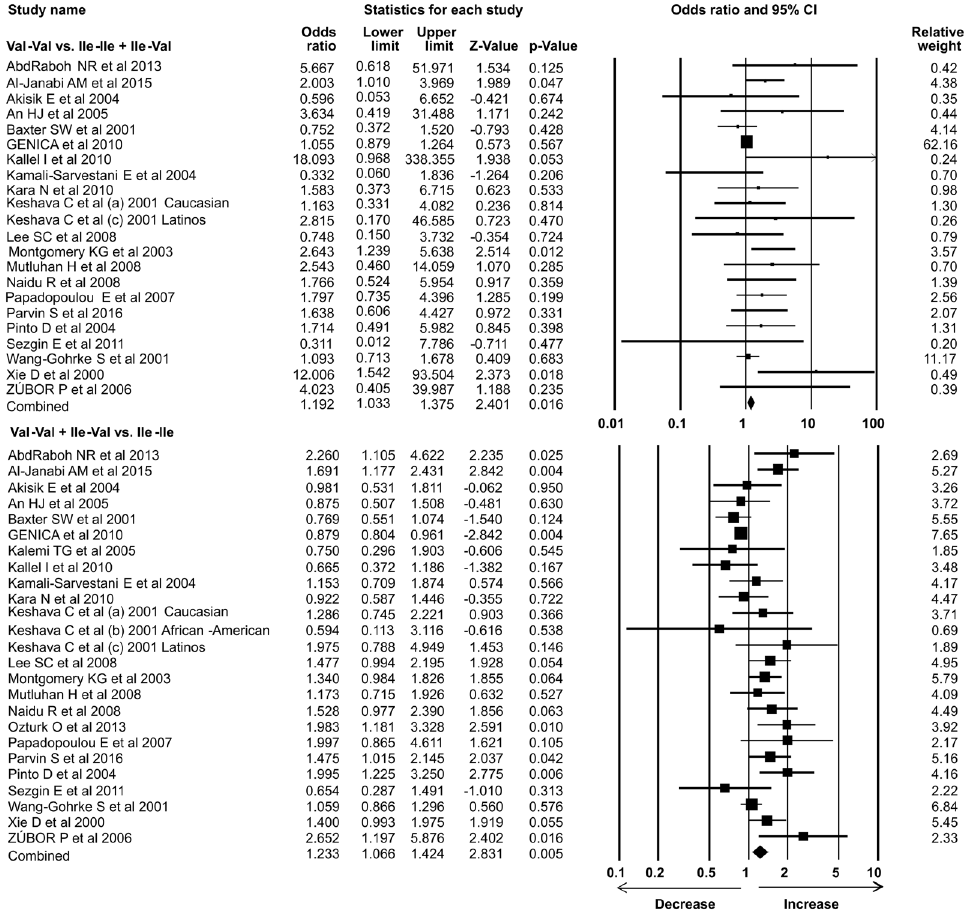
Figure 5. Forest plot: Genotypic (Recessive: Val-Val vs. Ile-Ile + Ile-Val; Dominant: Val-Val + Ile-Val vs Ile-Ile) analysis of studies in which RFLP used as detection method for Her2 Ile 655 Val (rs1136201) gene polymorphism and evaluation of its association with increased risk of breast cancer. Black squares represent the value of OR and horizontal line indicates 95% Confidence Interval (CI) of odds ratio